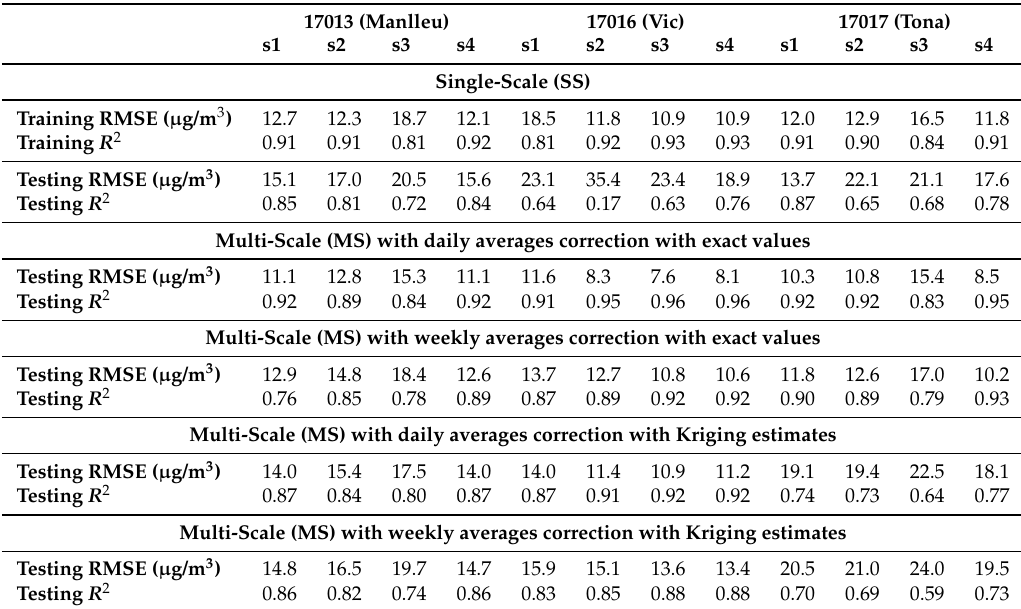
Table 4. Training RMSE, R2 and total testing average RMSE for nodes 17013, 17016 and